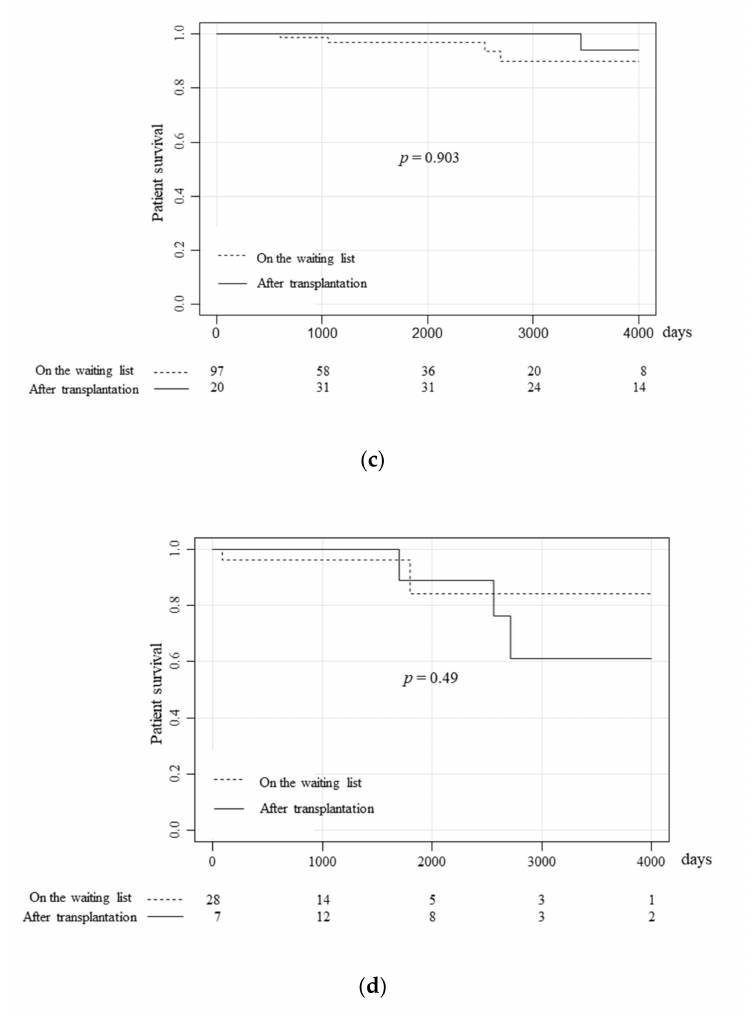
Figure 2. The prognoses of patients on the waiting list and pancreas transplantation recipients. The overall survival of patients on the waiting list and pancreas transplantation recipients were compared using Simon and Makuch’s time-dependent Kaplan-Meier curves for the overall study population ( a ), the SPK group ( b ), the PAK group ( c ), and the PTA group ( d ). ( a ) The survival rates of patients on the waiting list at 1, 5 and 10 years were 98.4%, 90.3%, and 78.1%, respectively, while those after transplantation significantly improved ( p = 0.029) to 100%, 97.5%, and 88.9%, respectively. ( b ) The survival rates of patients waiting for SPK at 1, 5, and 10 years were 98.2%, 89.4%, and 75.4%, respectively, while those after SPK also significantly improved ( p = 0.026) to 100%, 94.6%, and 88.8%, respectively. ( c ) The survival rates of patients waiting for PAK at 1, 5, and 10 years were 100%, 96.9%, and 89.8%, respectively, while those after PAK tended to be better, at 100%, 100%, and 94.1%, respectively, although this di ff erence was not statistically significant. ( d ) The survival rates of the patients waiting for PTA at 1, 5, and 10 years were 96.3%, 84.3%, and 84.3%, respectively, while those of patients who received PTA were 100%, 88.9%, and 61.0%,